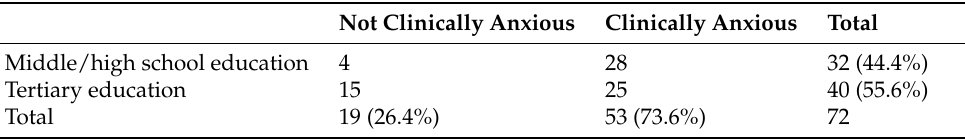
Table of observed frequencies of maternal education groups by clinical anxiety diagnosis groups.